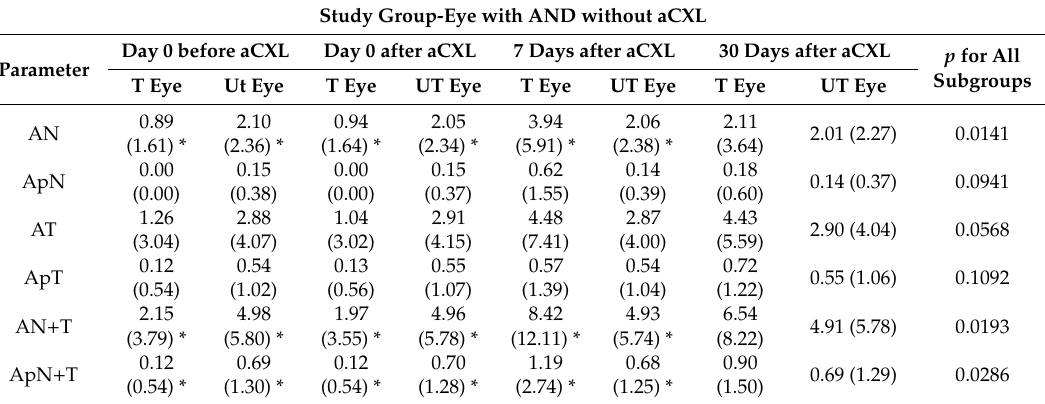
Table 2. Comparison of autofluorescence parameters between eye treated for keratoconus and the fellow, untreated eye. Parameters presented in mm 2 as a mean and (SD).